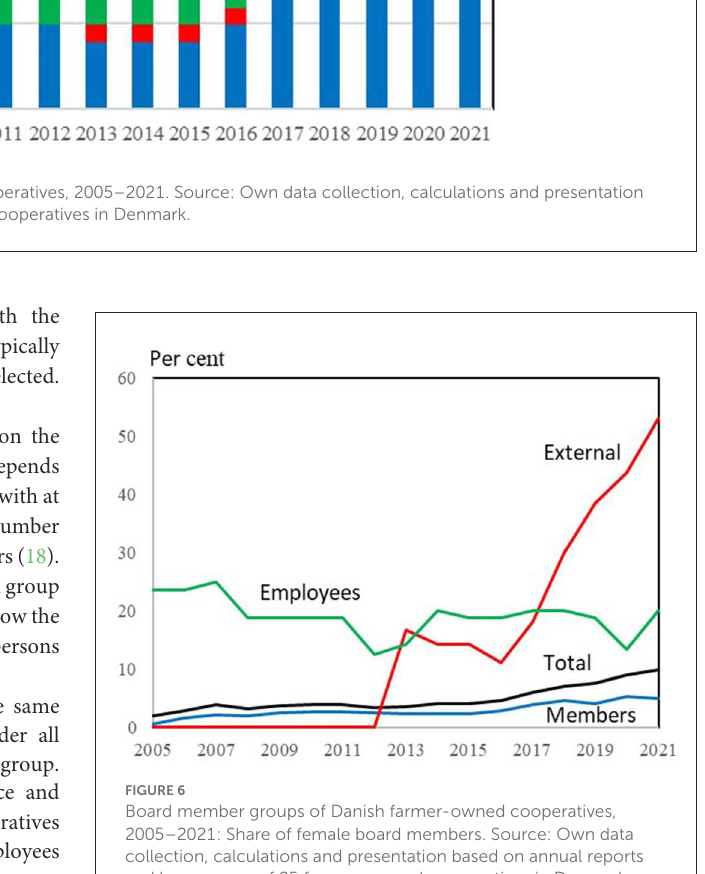
FIGURE6 Board member groups of Danish farmer-owned cooperatives, 2005–2021: Share of female board members. Source: Own data collection, calculations and presentation based on annual reports and homepages of 25 farmers owned cooperatives in